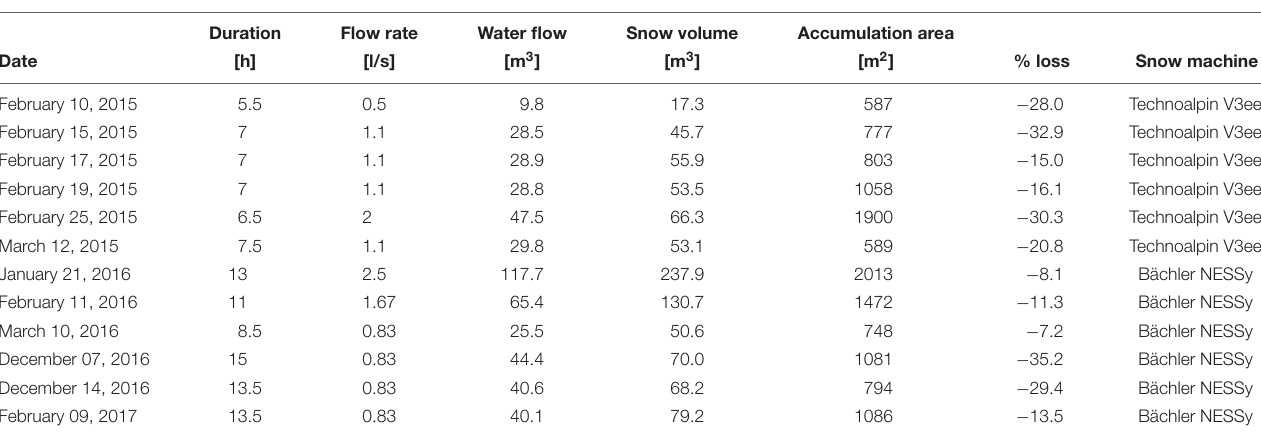
TABLE 1 | Machine settings and measured results for the different experiments. Duration Flow rate Water flow Snow volume Accumulation